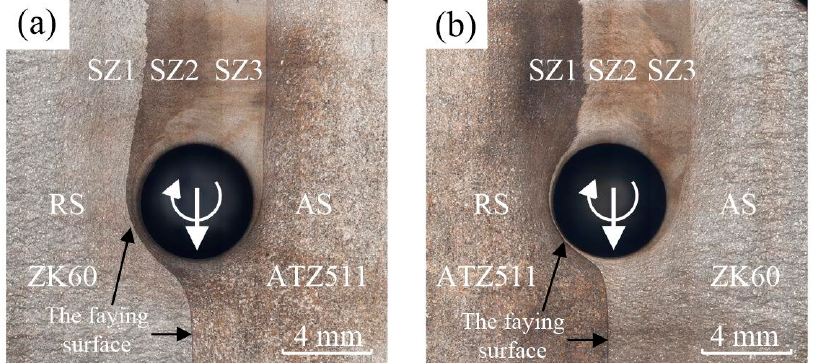
Figure 3. OM images at horizontal plane with depth of 1.2 mm around keyhole of the two welded joints: ( a ) ZK60/ATZ511 joint, ( b ) ATZ511/ZK60 joint.